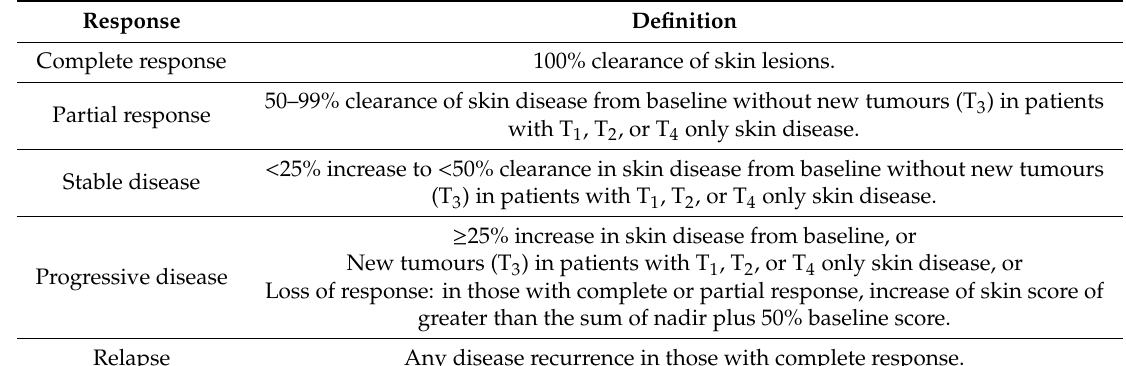
Table 1. Standardised skin response definitions (utilising the modified Severity Weighted Assessment Tool score)